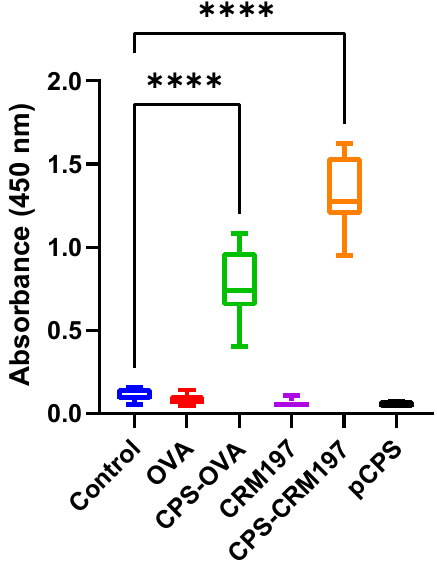
Figure 2. Mice antibody response to vaccination. The immunogenicity of antigens was tested using serum from different groups of immunized mice (CPS-CRM197, CRM197, CPS-OVA, OVA, pCPS and control groups). Immunoblot. Crude CPS sample was loaded on 12.5% acrylamide gel, separated by SDS-PAGE and transferred to the PVDF membrane. The numbers on the second line identify individual animals.